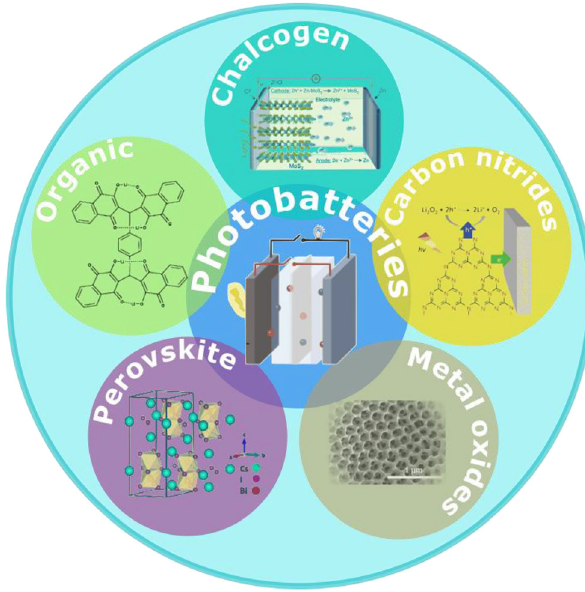
Figure 13: Schematic diagram summarizing the main contents of thisreview, i.e. ,maingroupsofnanomaterialsthatareusedasPEin PBATs. Copyright 2021, American Chemical Society and 2016, Royal Society of